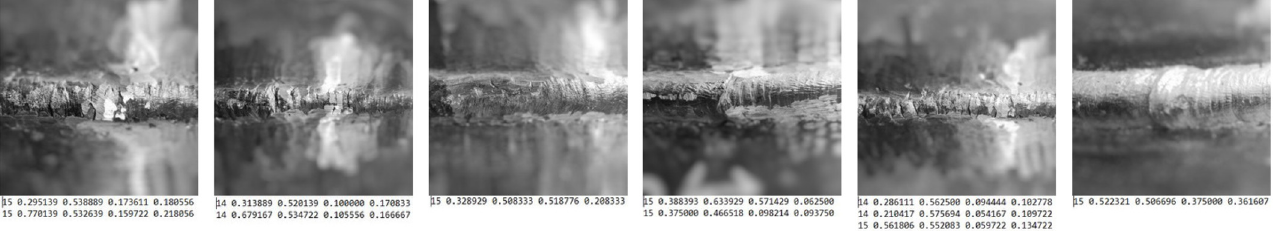
Figure 7. Examples of preprocessed and labeled image data.